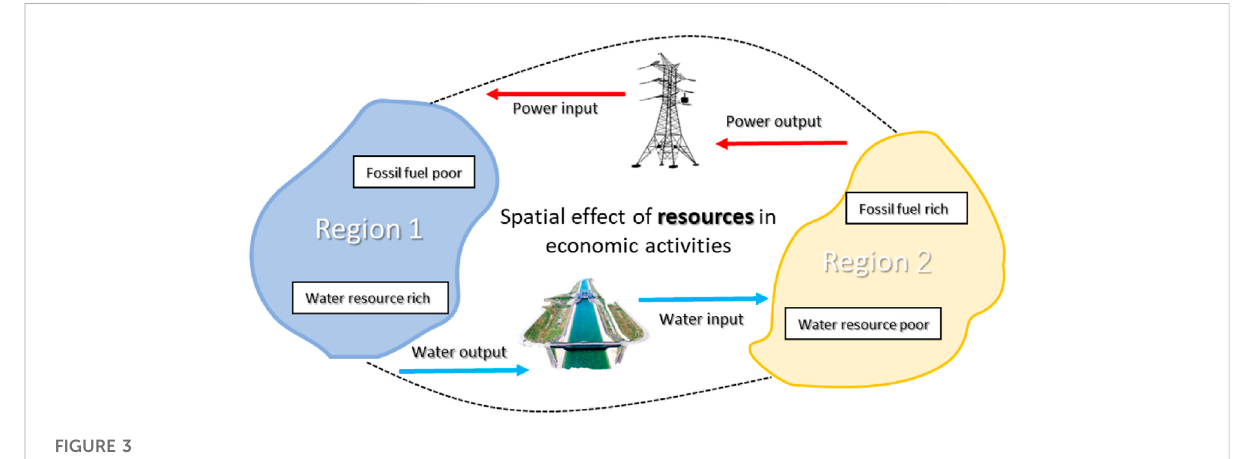
FIGURE 3 Spatial effect mechanism of resource